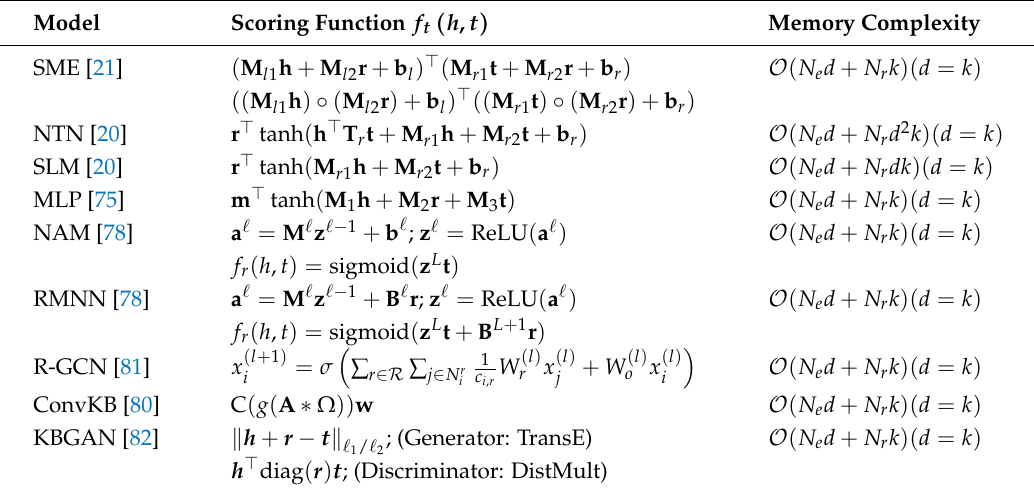
Figure 5. Framework of the KBGAN model. Table 4. Comparison of neural network-based models in terms of scoring functions and memory